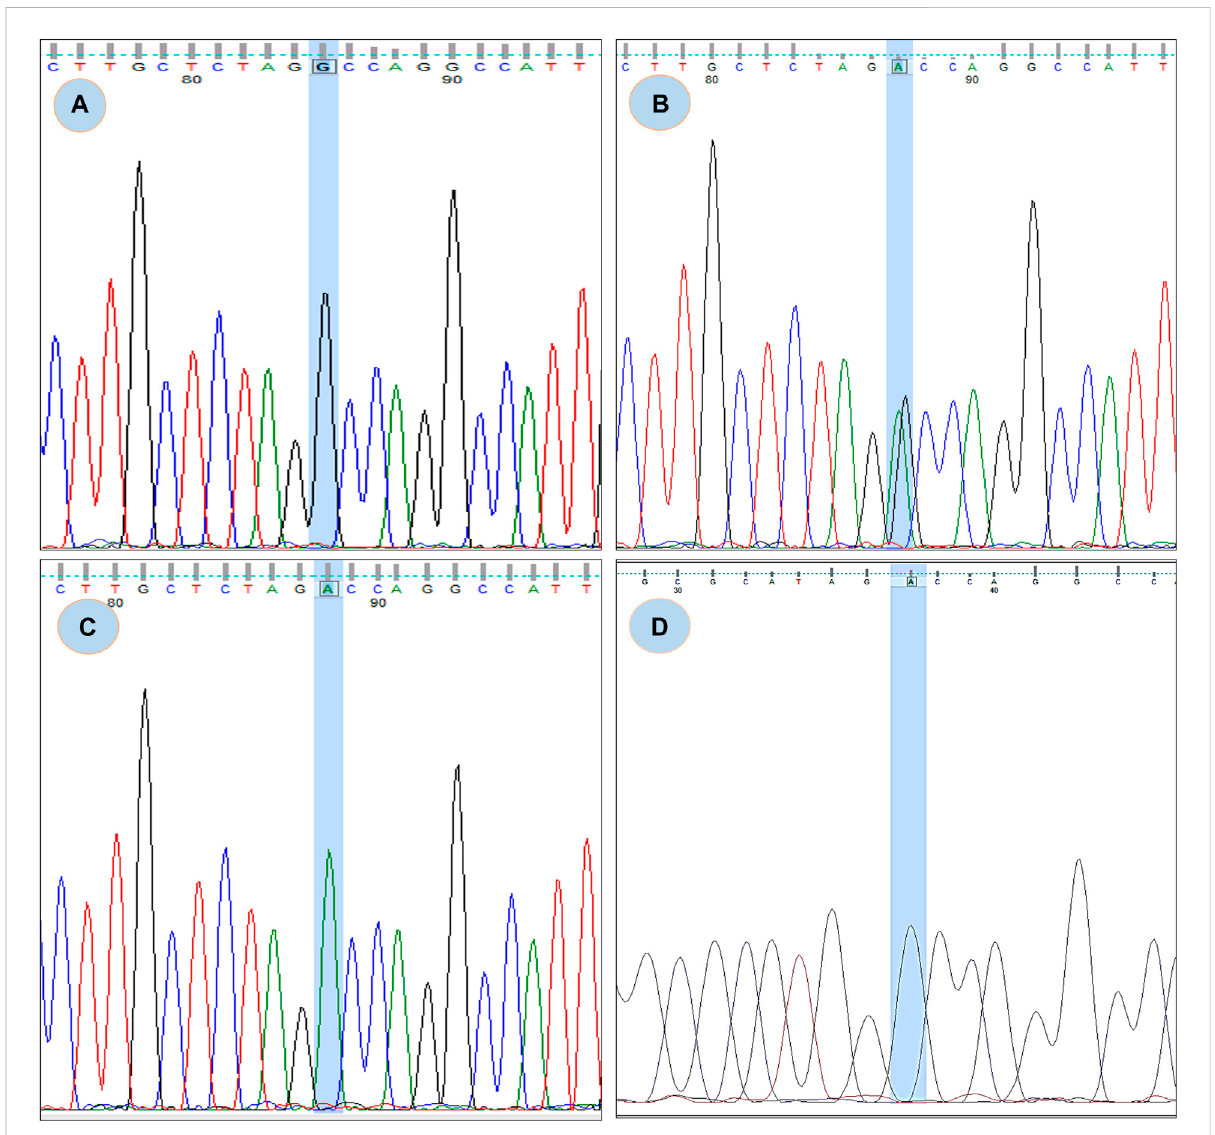
FIGURE 3 Chromatogramofrs180177314; (A) showingGGgenotype, (B) showingGAgenotype, (C) showingAAgenotype (D) ChromatogramfromCDNA sequence showing no sign of splicing